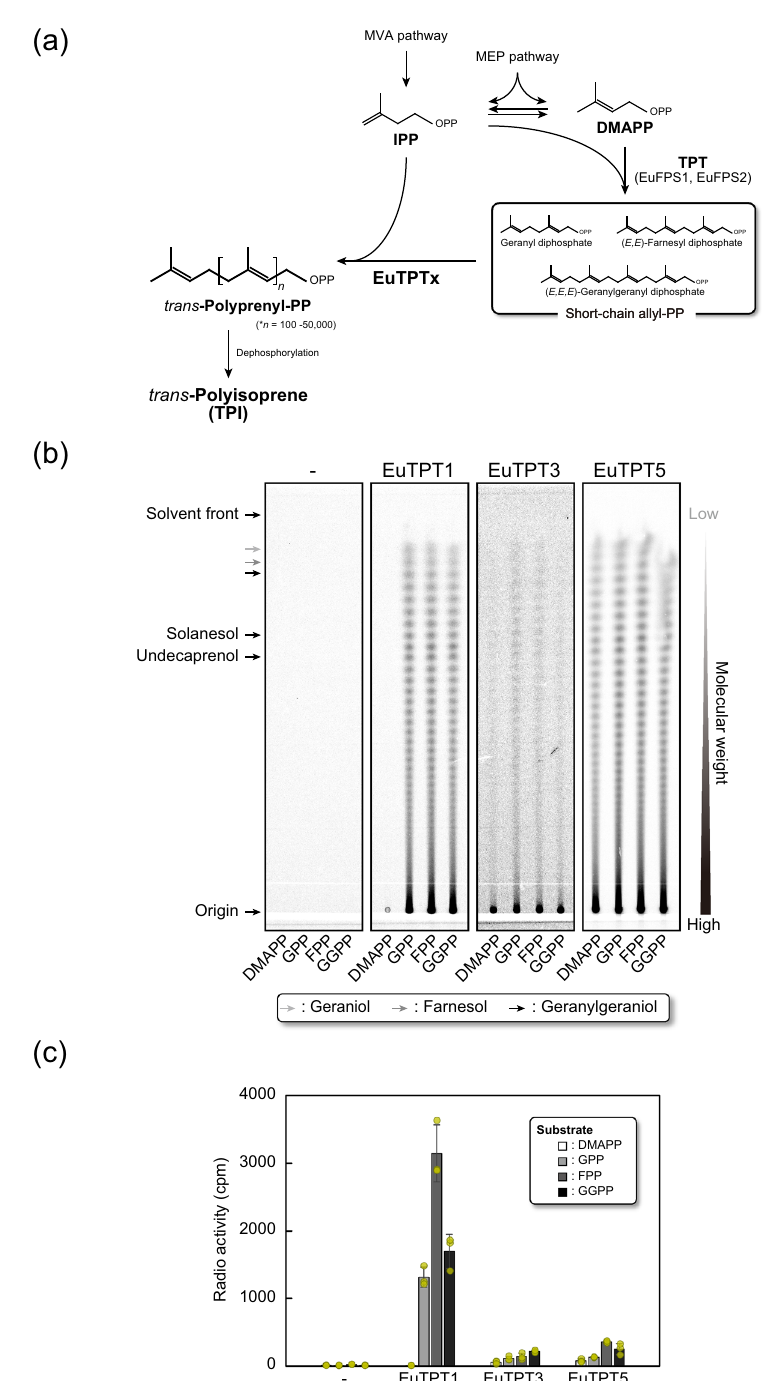
Fig. 1 Biosynthetic pathway of trans -polyisoprene and in vitro analysis of EuTPTx function. a Flowchart of the biosynthesis pathway of linear trans - polyprenyl diphosphate mediated by prenyltransferase. DMAPP dimethyallyl diphosphate, IPP isopentenyl diphosphate, MVA mevalonate, MEP 2- C - methyl- D -erythritol 4-phosphate. b Reversed-phase thin-layer chromatography (RP-TLC) analysis of reaction products generated by heterologously expressed EuTPTx proteins. [1- 14 C]IPP was incubated with EuTPTx and the allylic substrates, followed by extraction of the 14 C-labeled reaction products, dephosphorylation using acid phosphatase, and separation by RP-TLC. Geraniol (C 10 ), farnesol (C 15 ), geranylgeranyol (C 20 ), solanesol (C 45 ), and undecaprenol (C 55 ) were used as standards. Geraniol, farnesol, and geranylgeraniol are indicated by light gray, gray, and black arrows, respectively. Origin and solvent front are indicated by black arrows. -: control incubated without any enzyme. c Relative activities of EuTPTx using allylic substrates. Allylic substrates were incubated with [1- 14 C]IPP. Unreacted [1- 14 C]IPP was removed and the radioactivities of the 14 C-labeled reaction products were measured using a liquid scintillation counter. All samples were analyzed in independent assays ( n = 3). Standard deviation was used to calculate error bars. Individual data points are shown in yellow